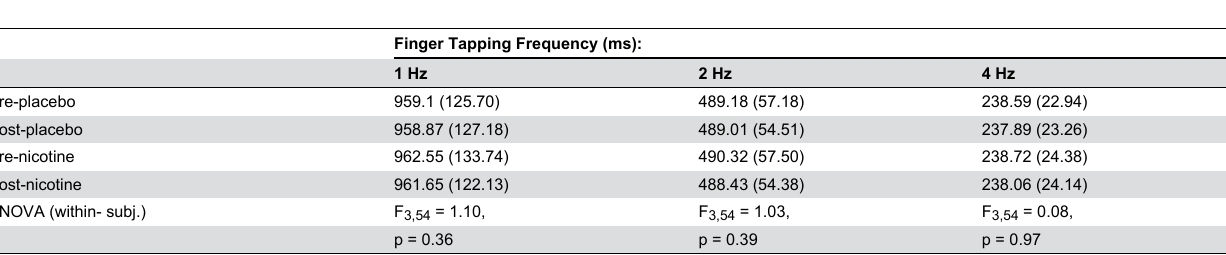
Table 1. Finger tapping frequencies across all experimental conditions.